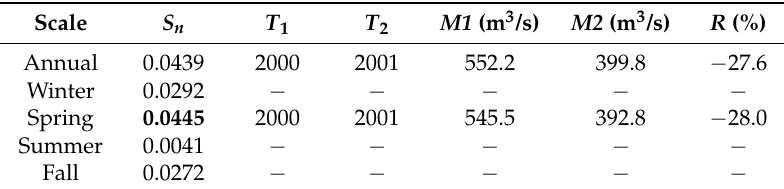
Table 6. Analysis of the temporal variability of annual and seasonal maximum daily flows from 1980 to 2014 using the Lombard